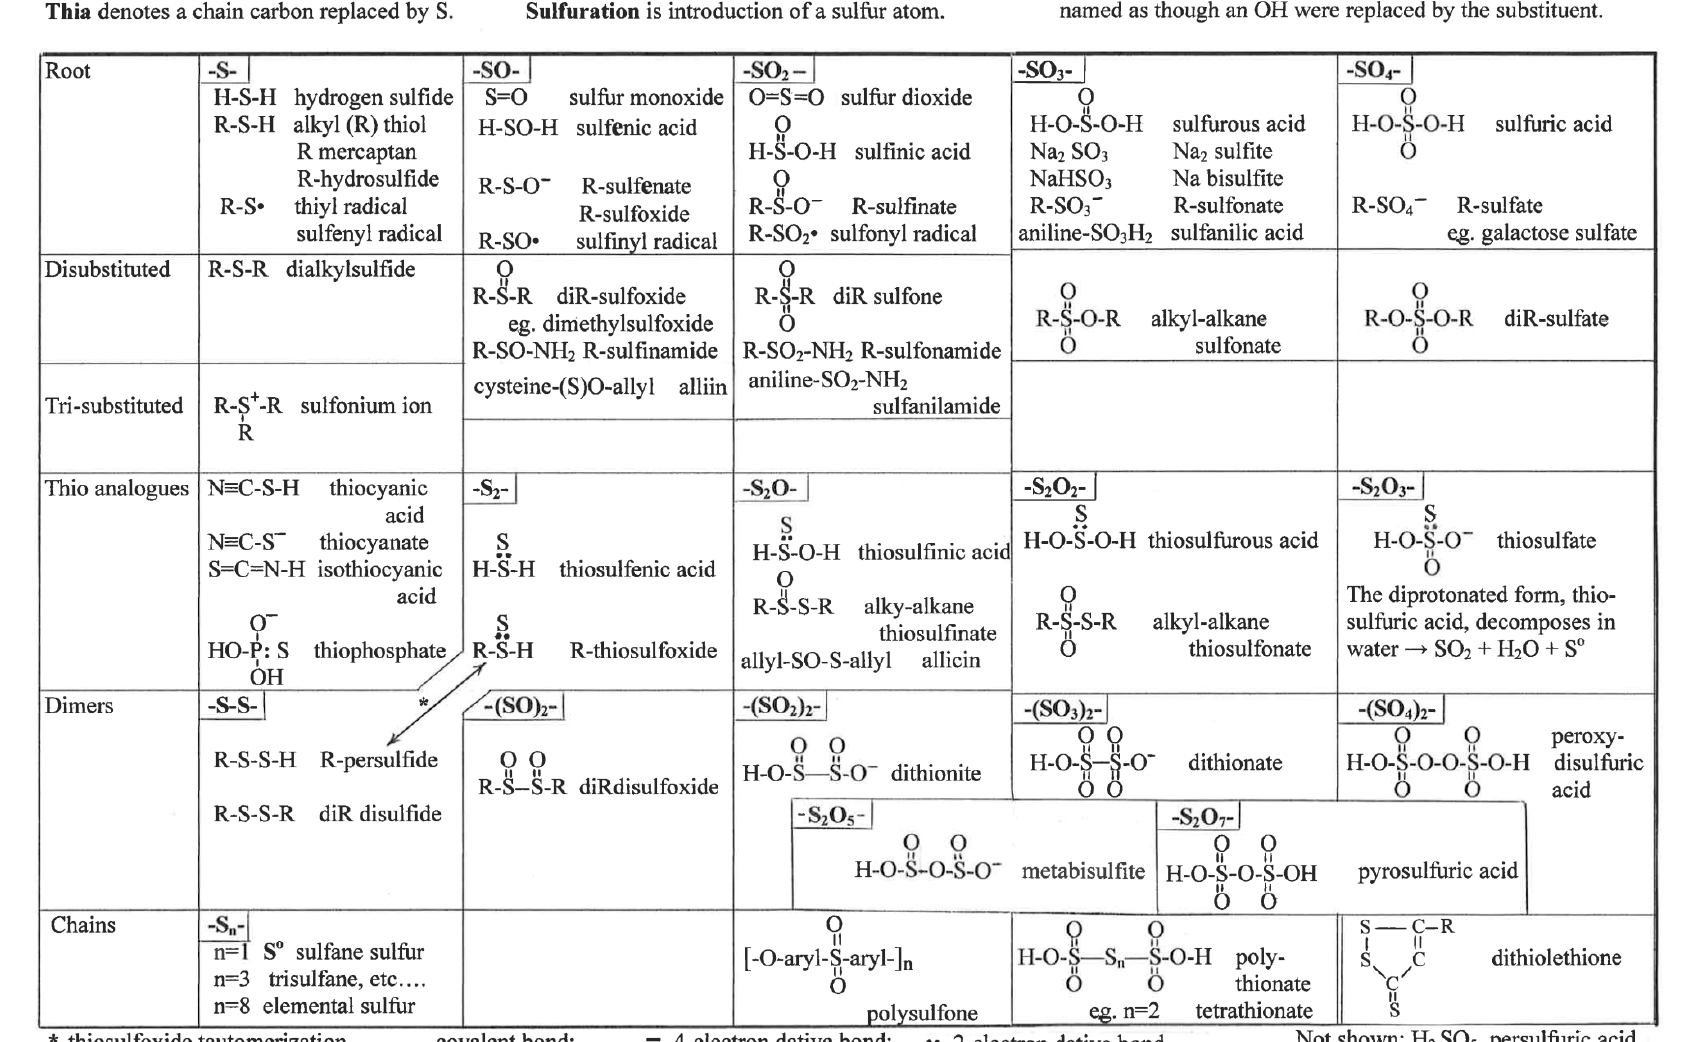
Table 1. Structure and nomenclature of sulfur